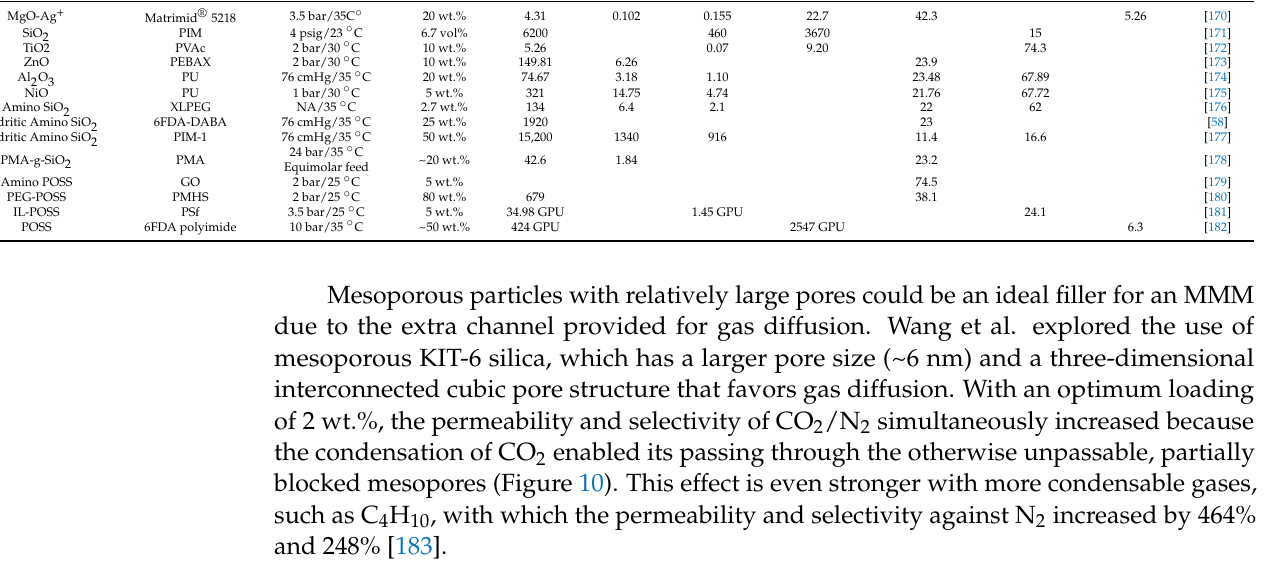
Table 5. Transport properties of unmodified oxide nanoparticle/polymer mixed matrix membranes. Nanoparticles Polymers